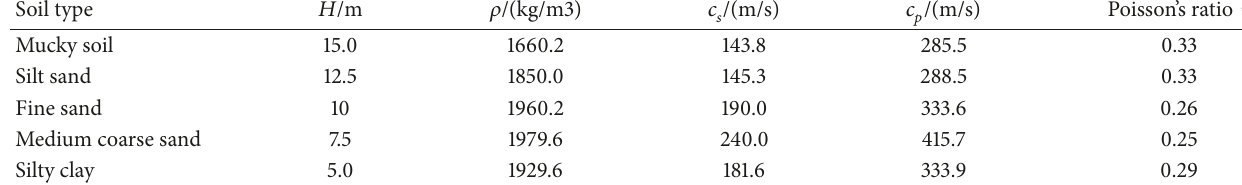
Table 1: Soil parameters.